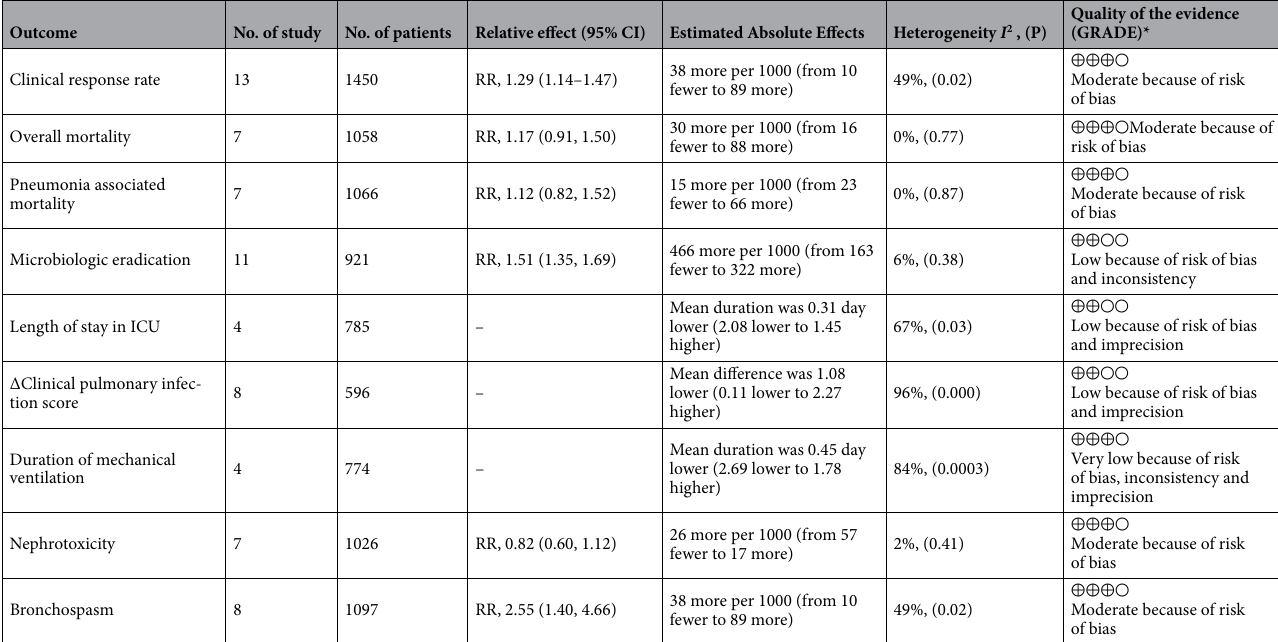
Table 2. Grading of recommendations assessment, development, and evaluation evidence profile for the role of adjunctive aerosolized amikacin in outcomes of the meta-analysis. ⊕⊕⊕○ moderate, ⊕⊕○○ low,